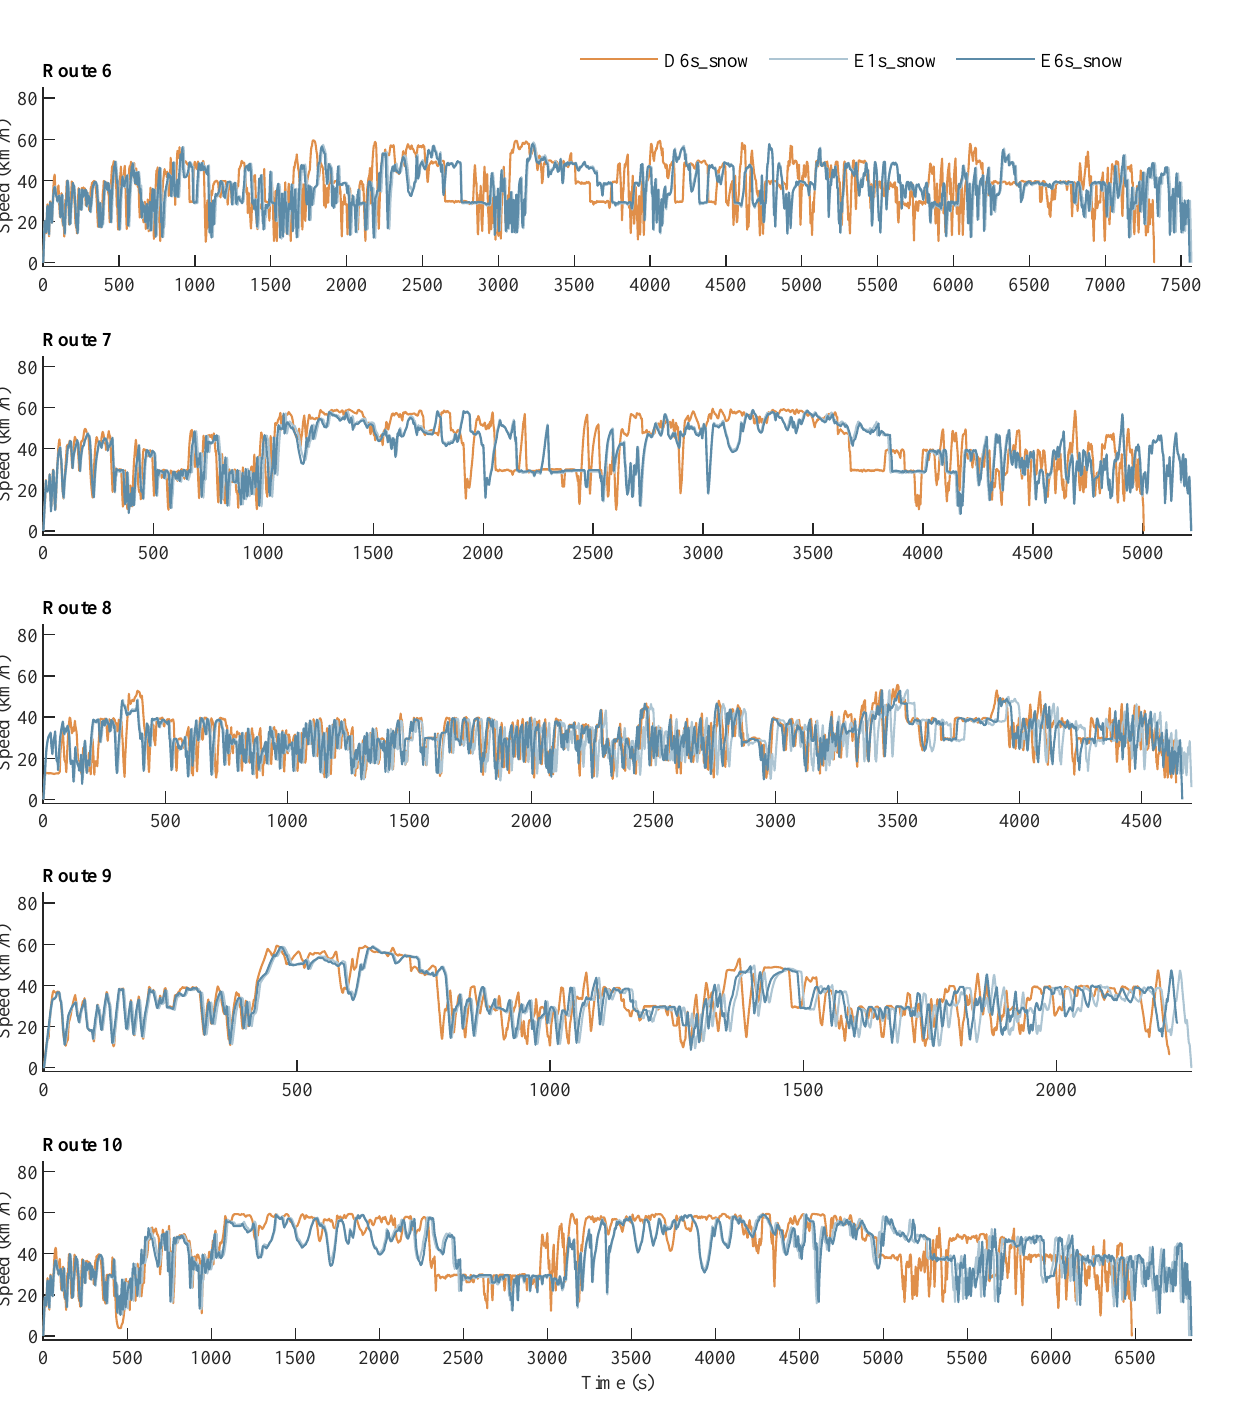
Figure A4. Speed performance with the snow load on routes